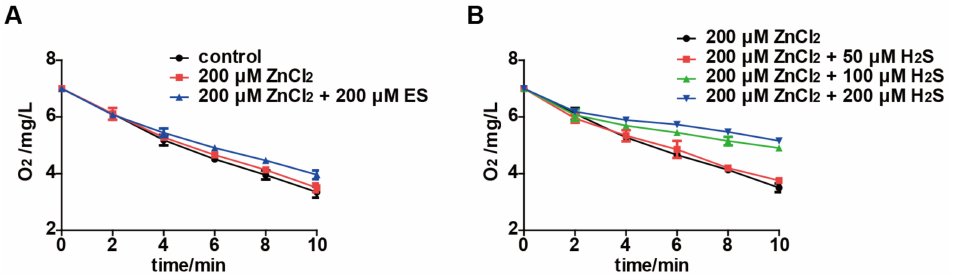
Figure 3. Zn 2+ prevents H 2 S from inhibiting yeast from consuming O 2 . ( A ) Oxygen consumption was determined after incubating 200 µ M ZnCl 2 with S. cerevisiae resting cells in the presence or absence of 200 µ M elemental sulfur for 10 min. ( B ) Oxygen consumption was determined after S. cerevisiae resting cells were incubated with different concentrations of H 2 S for 10 min in the presence of 200 µ M ZnCl 2 . The S. cerevisiae resting cells used in the study were OD 600nm = 2.0. The 2% glucose was added as the fuel of the electron transport chain. Data are averages of three parallel experiments with standard deviations. ES, elemental sulfur.